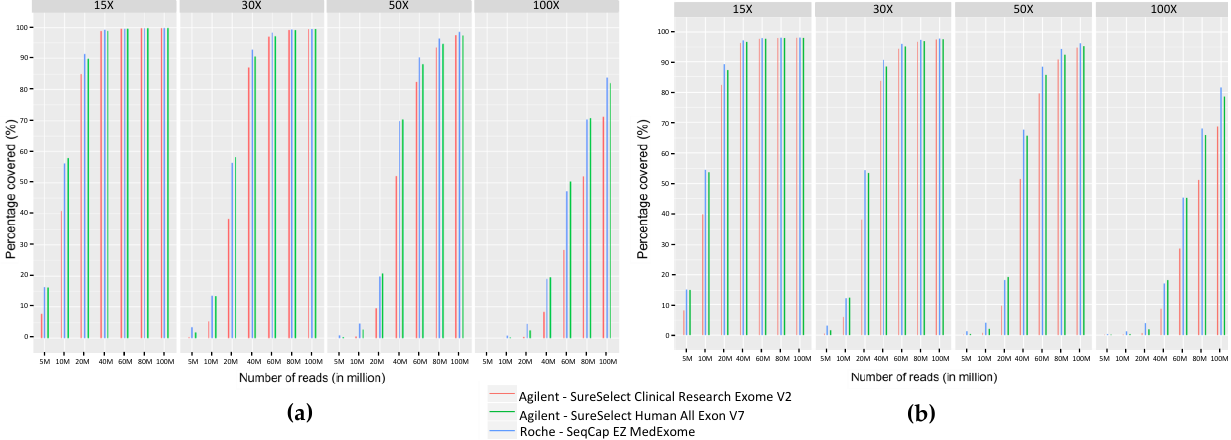
Figure 4. Comparison of coverage as percentage of bases covered at fixed depths (15X, 30X, 50X, and 100X) for different sequencing efforts (5M, 10M, 20M, 40M, 60M, 80M, and 100M) obtained with the three ES kits on ( a ) the panel of neuromuscular genes used in diagnosis in the laboratory [3] and ( b ) OMIM disease-associated genes.